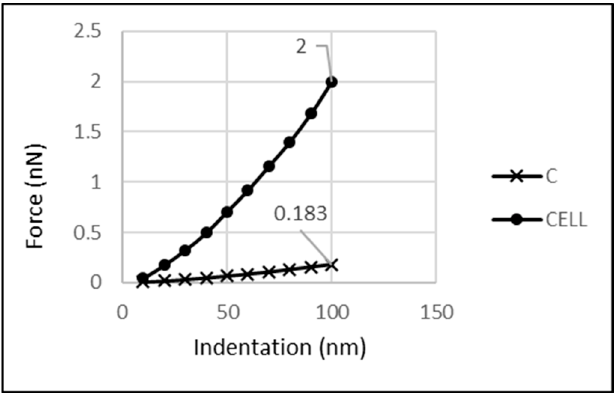
Figure 8. Calculated reaction force carried by the cytoplasm vs. the complete